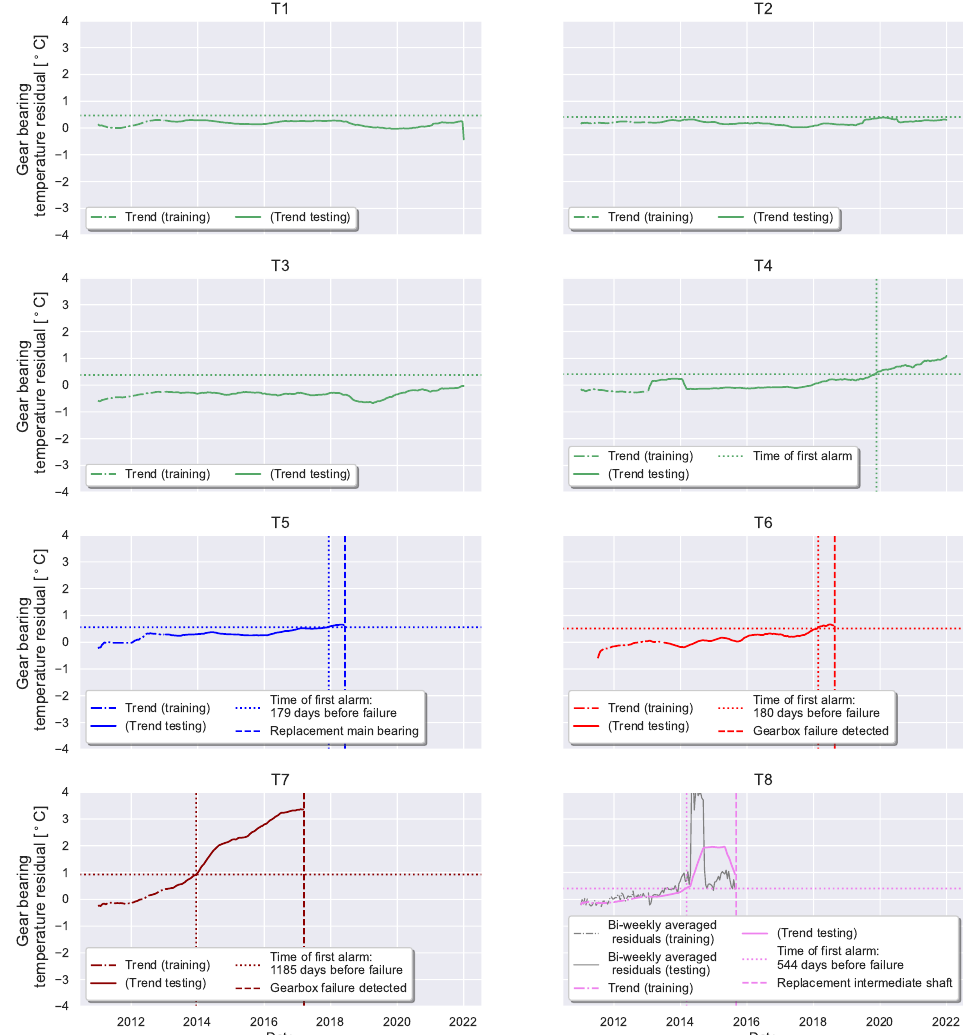
Figure 9. Trend evolution of the residuals for the eight investigated turbines (solid lines). For T8, also the biweekly trend is reported. For each turbine, the thresholds (horizontal dotted lines) and the time the trend reaches the threshold (vertical dotted line) are shown. The trend during the training period is shown as a dash-dotted line, and the trend in the testing period is shown as a solid line. The time the failure is detected (or when that is unknown, the time component is replaced) is shown as a vertical dashed line. The legend reports the number of days between the time the threshold is exceeded and the time the failure is